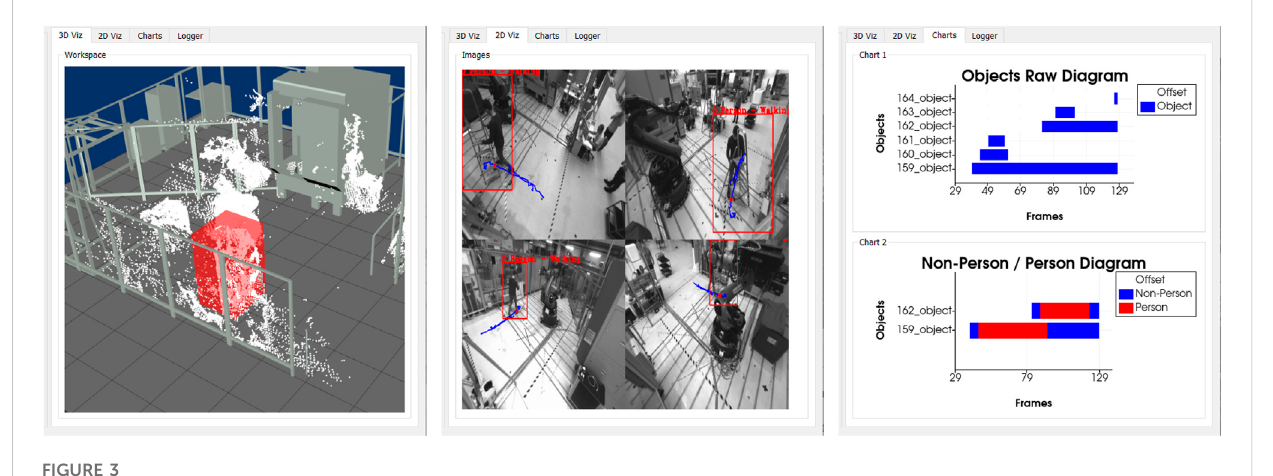
FIGURE 3 Workspace viewer (left), image viewer (center), chart viewer